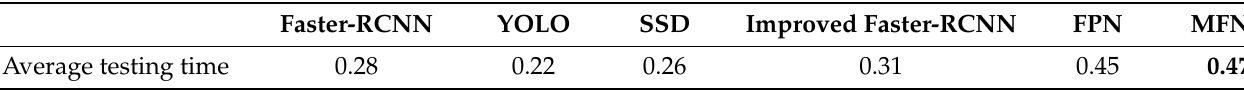
Table 5. Average testing time per image in different frameworks.